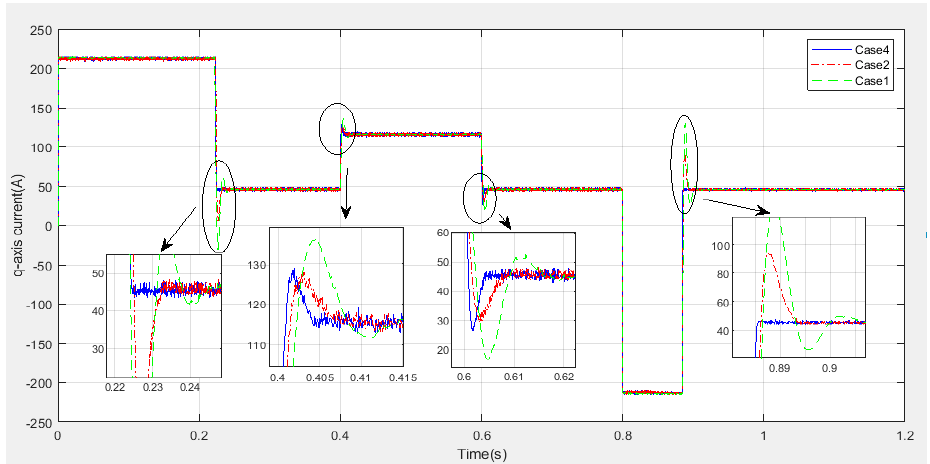
Figure 5. The q-axis current response in Case 1, Case 2 and Case 4.